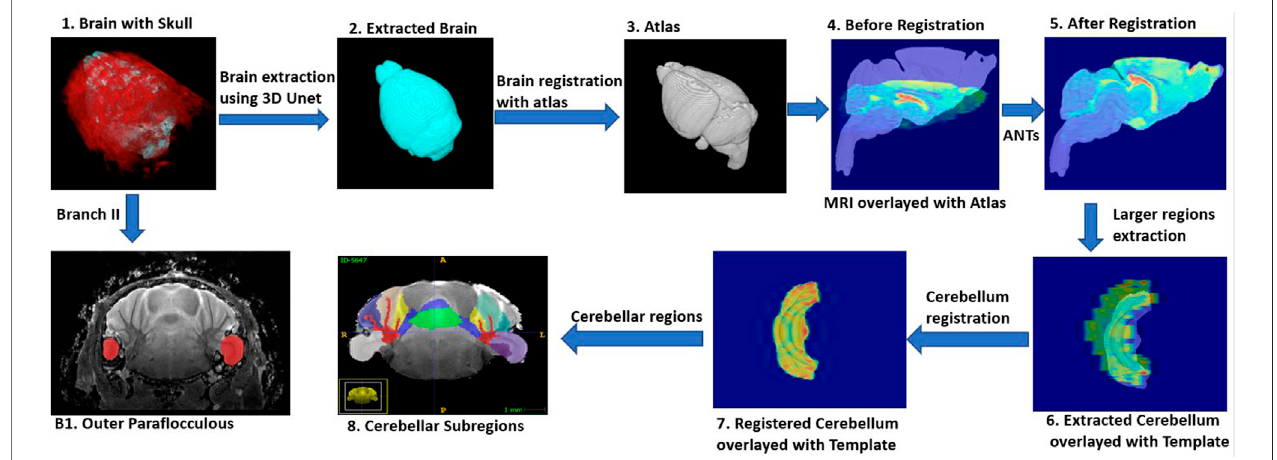
FIGURE 1 | DeepBrainIPP work fl ow (Steps 1 – 5) skull stripping followed by registration of the segmented brain to an atlas (Step 6) Large brain structures are segmented (Steps 7 – 8) To segment sub-cerebellar regions (colors in Step 8), DeepBrainIPP registers the cerebellum to an in-house generated template. Step B1 following Branch II shows direct segmentation of the outer para fl occulus mask (red color) overlayed with the raw image. This direct segmentation outperformed the template registration approach in the case of small